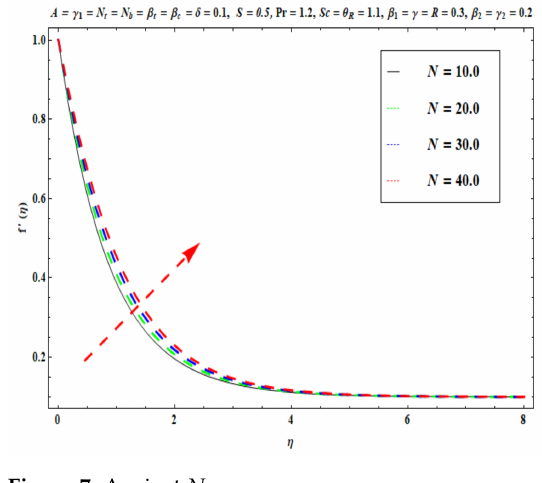
Figure 7. Against N .